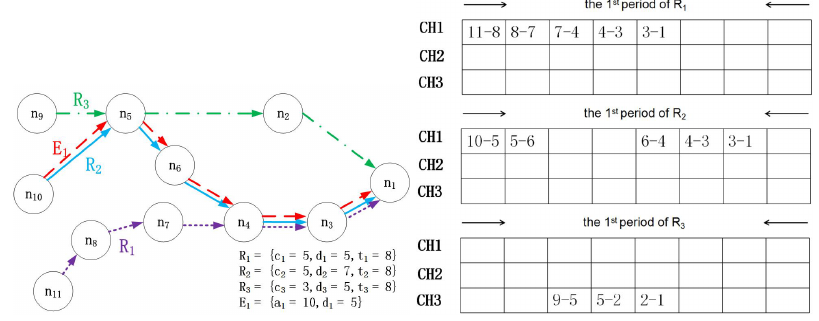
Figure 6. An example for selecting the path based only on blocking and intersections.